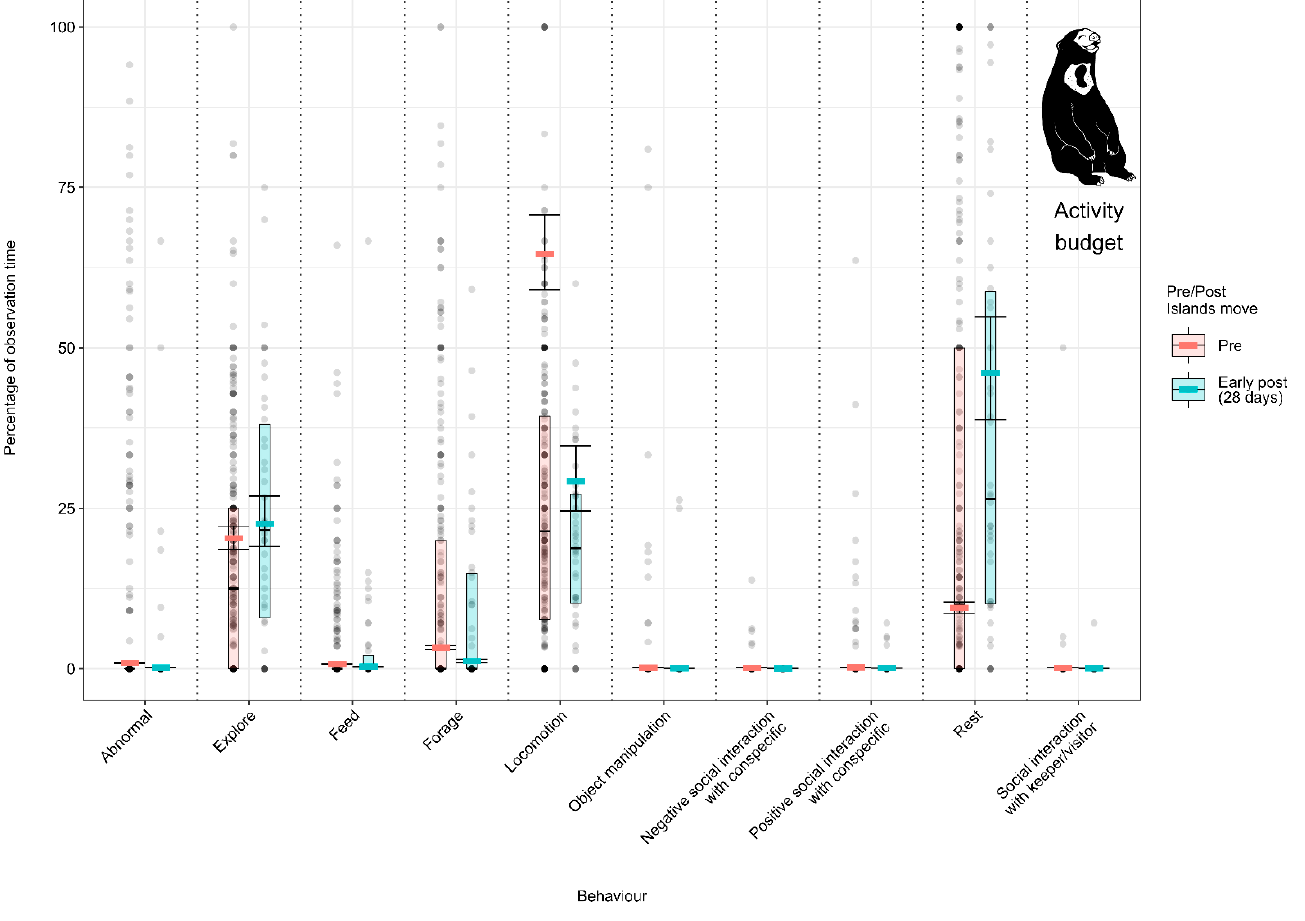
Figure 4. Proportion of time Malayan sun bears spent performing each behaviour (expressed as a percentage of the total observation time) under the pre-, early-post- and post-enclosure-move conditions. The model’s fitted values are represented by coloured horizontal lines, and their respective 95% confidence intervals are depicted as black error bars. Coloured boxes with black horizontal lines depict the medians and quartiles of the response. Grey dots represent raw data points, shaded according to frequency (dark indicates many observations, light indicates few).